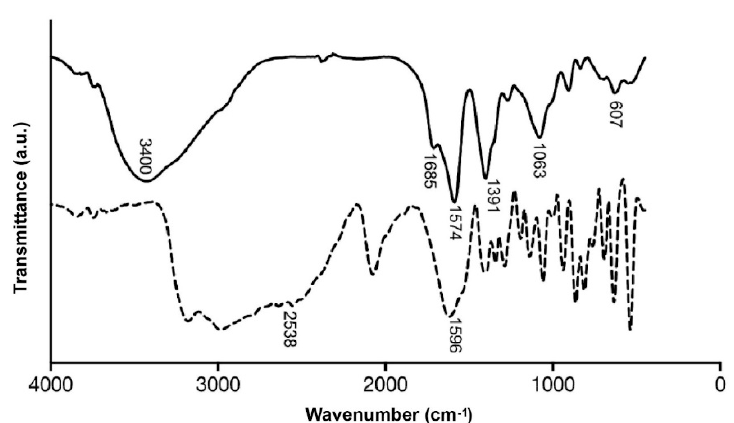
Figure 2. FTIR spectra of Cu 2 S NPs (complete line) and cysteine (dashed line). Interaction of the Cu metal surface with cysteine molecules was studied using FTIR spectroscopy.